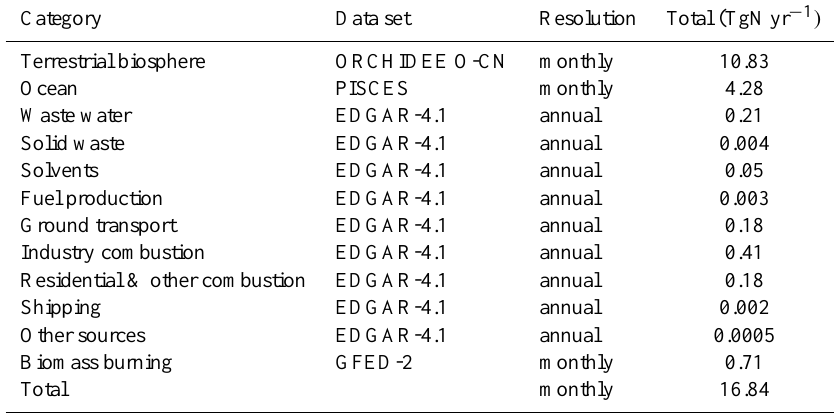
Table 2. Overview of the reference prior fluxes (OCNPIC) (totals shown for 2005).